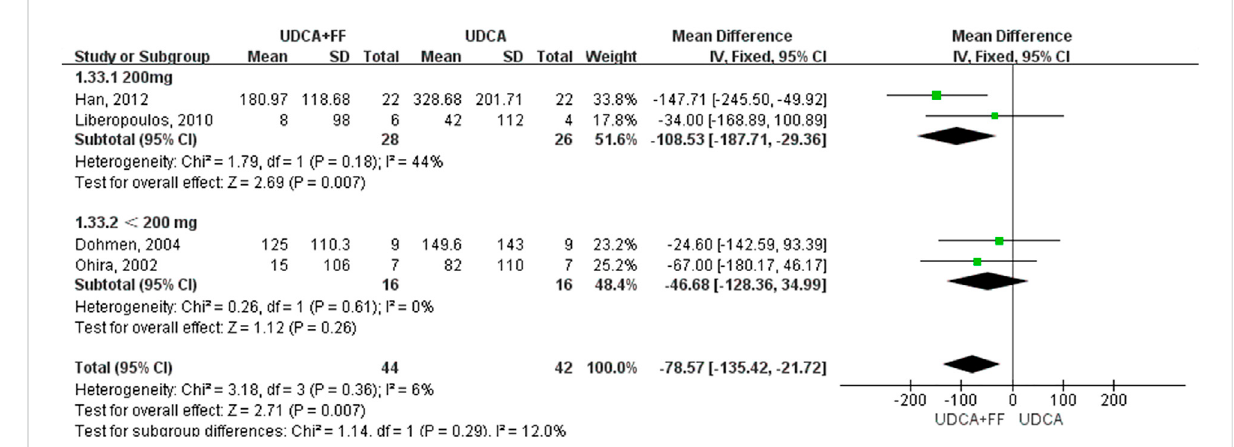
FIGURE 6 Subgroup analysis of GGT levels in PBC patients treated with monotherapy versus COM.